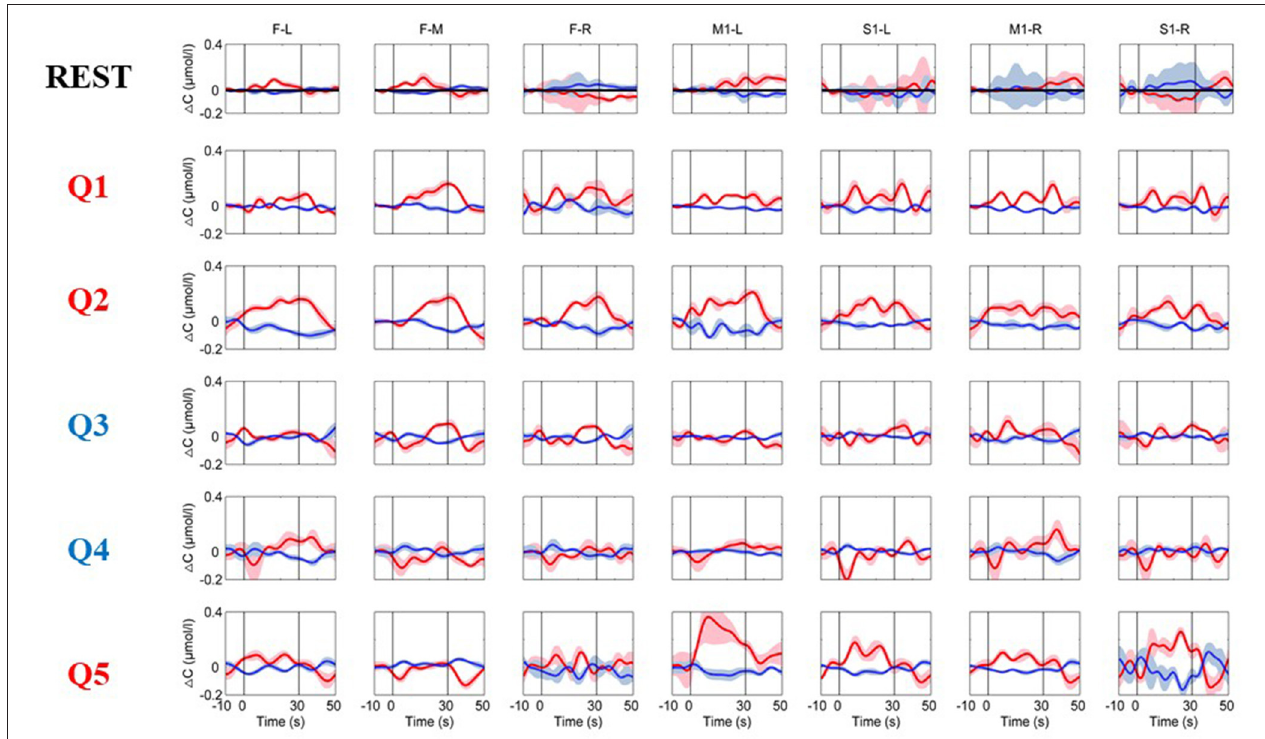
FIGURE 3 | The time courses of the changes in HbO and HbR concentrations were obtained from a healthy subject (Subject 2). The resting-state time course labeled “REST” refers to data acquired without MI activation and is illustrated as a reference for comparison with the question periods. Q1–Q5 represents the hemodynamic responses for the different questions Q1–Q5. The red numbers represent the ground-truth “yes” questions, while the blue numbers represent the ground-truth “no” questions. The red and blue lines represent HbO and HbR, respectively. The stimulus duration is indicated by the space between the two gray